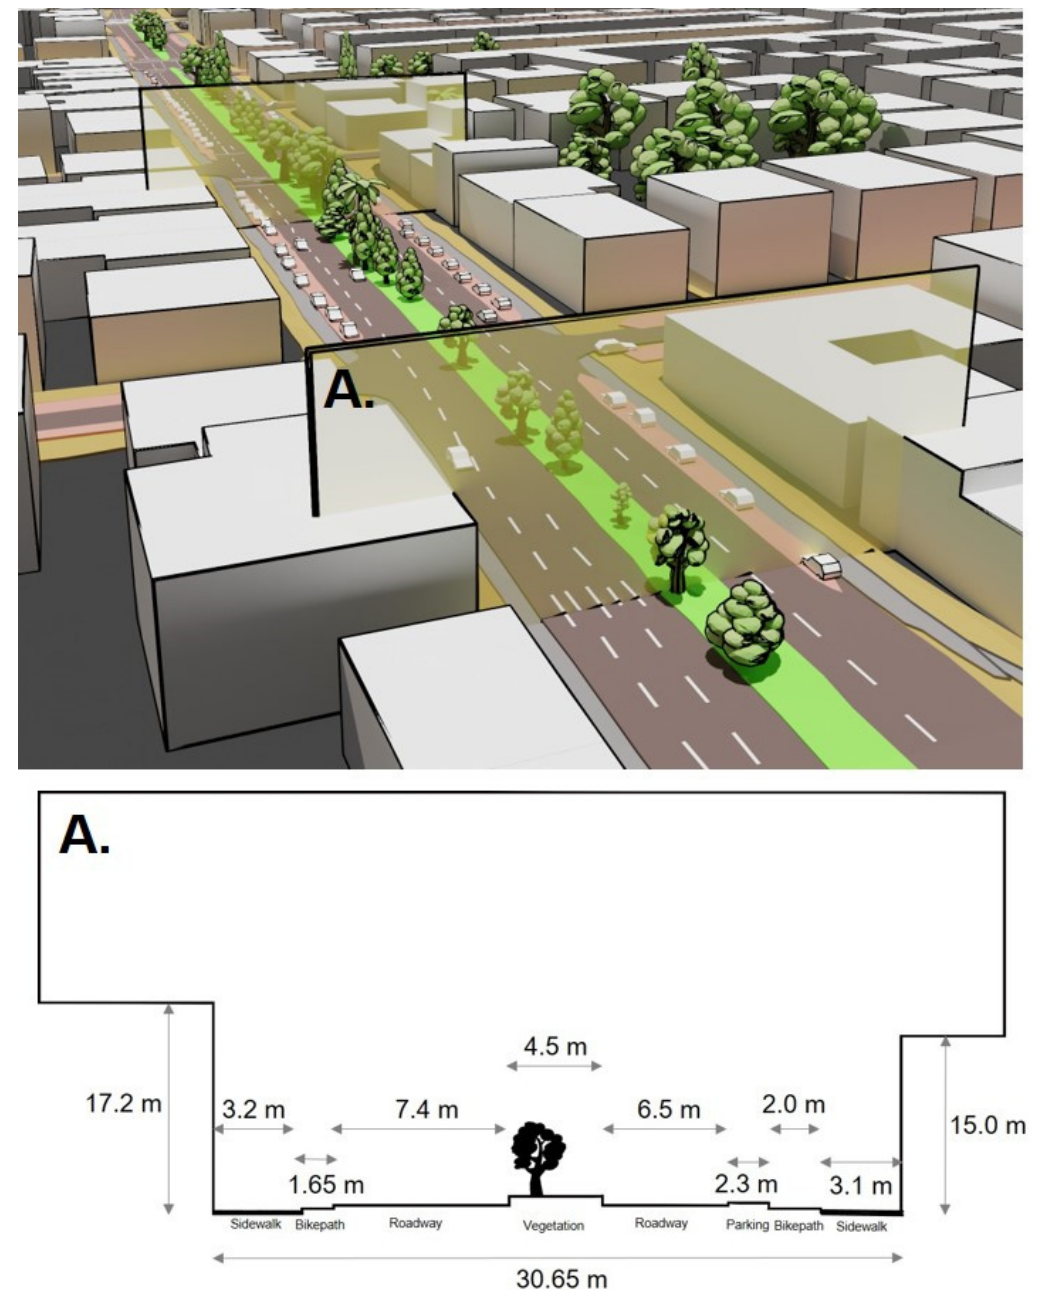
Figure 11. Combined output translated to 3D model with specific cross-section.